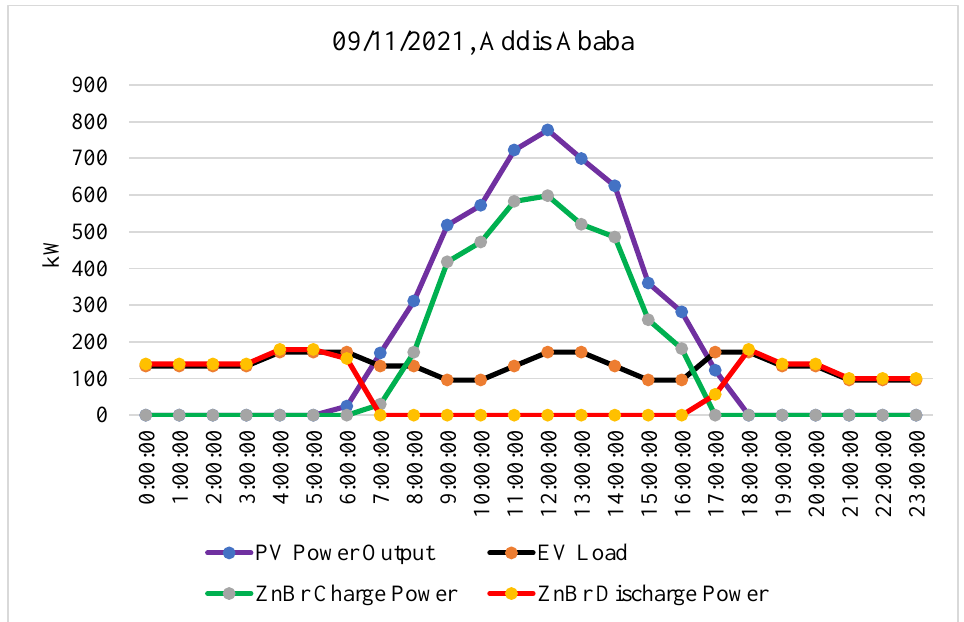
Figure 12. The best systems are those that match the energy demand, PV power output and charge/discharge of the battery bank.